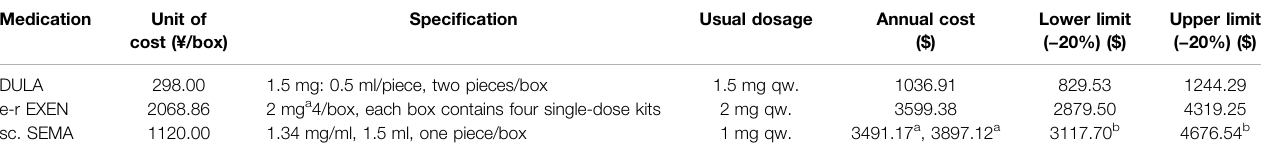
TABLE 3 | Costs of medications.